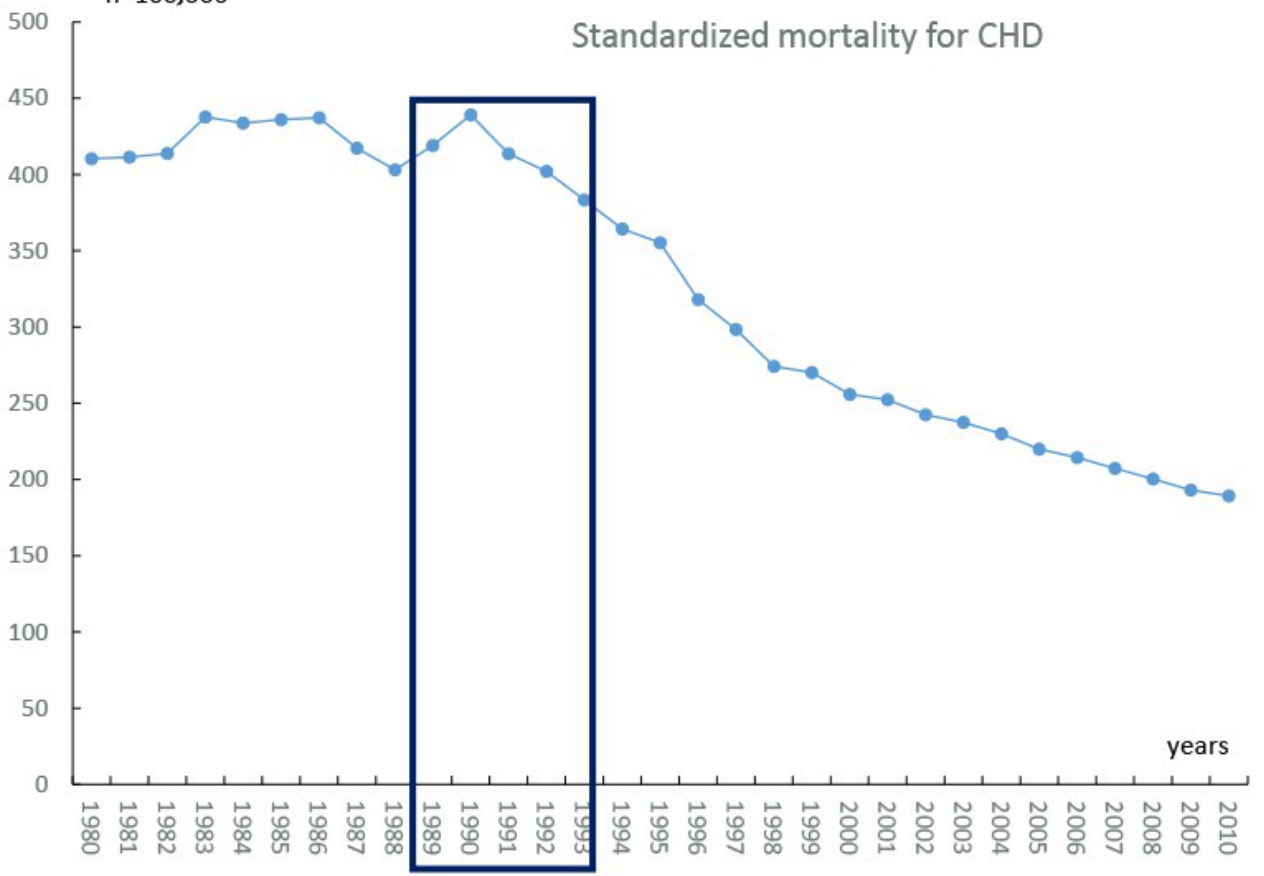
Figure 1. Development of standardized mortality of Czech men/100,000